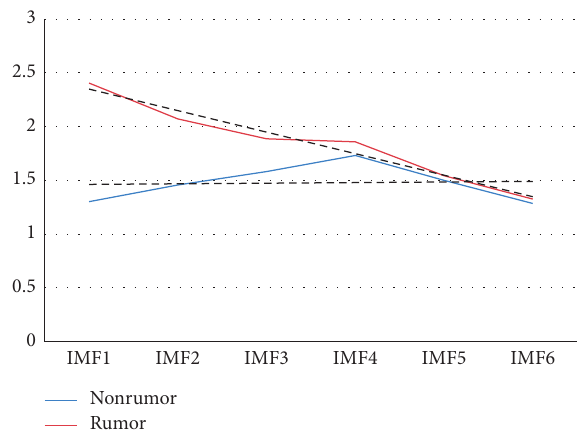
Figure 8: Distribution of rumor correlation integral.